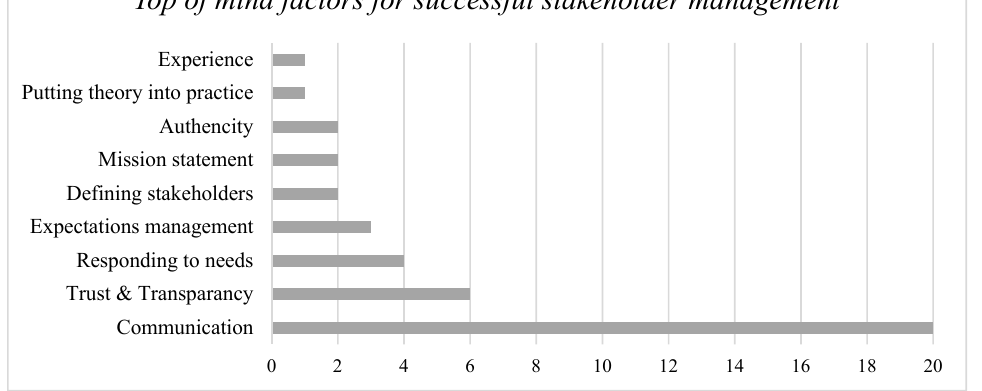
Figure 9. Top of mind success factors for stakeholder management according to USO respondents.